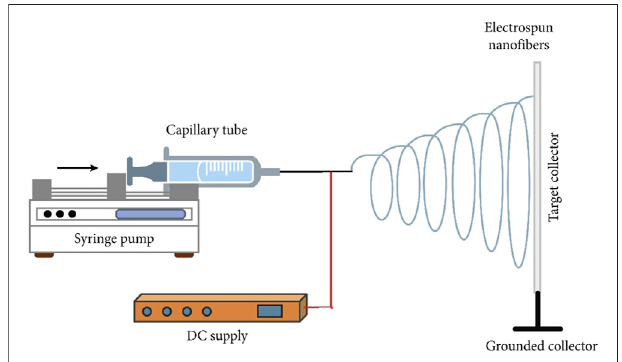
FIGURE 3 | The number of publications on the use of conventional methods to fabricate conductive scaffolds between 2017 to 2021 ( fi ve-year period). Data as of 1st September 2021 from Web of Science.